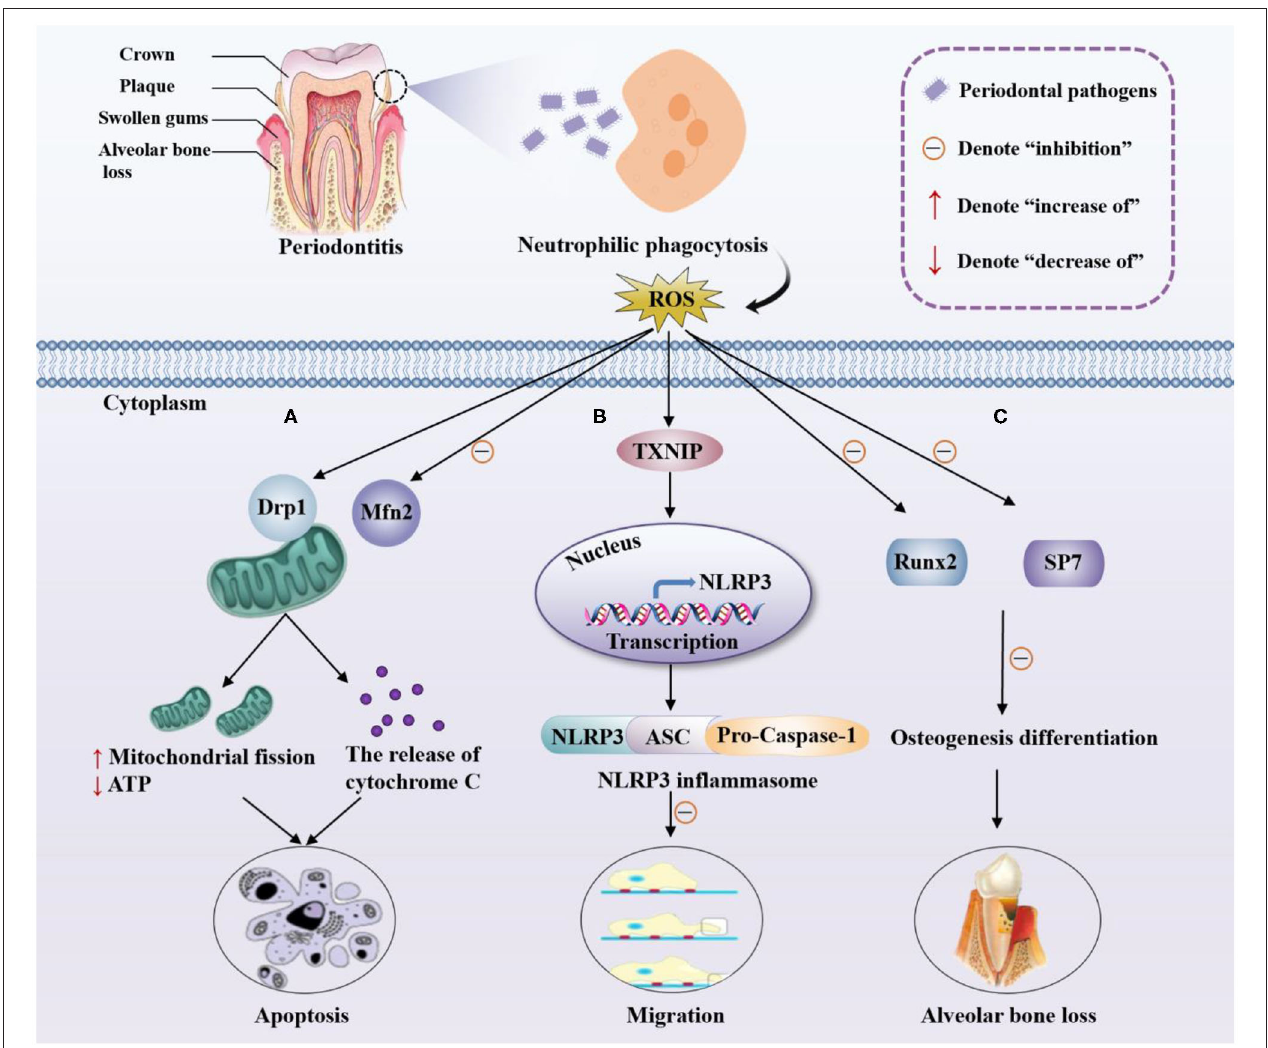
FIGURE 1 | Pathomechanism of periodontitis and ROS. Pathogens in dental plaque trigger the recruitment and activation of neutrophils, producing a large amount of ROS through phagocytosis. (A) ROS promote mitochondrial fission via the upregulation of Drp1 and downregulation of Mfn2 which is a mitochondrial fusion protein, reduce the production of ATP, and increase the release of cytochrome C, inducing the apoptosis of PDLSCs. (B) ROS trigger the combination of TXNIP and NLRP3, leading to the upregulation of the transcription of NLRP3, thereby activating the NLRP3 inflammasome and ultimately inhibiting the migration of PDLFs. (C) ROS inhibits the expression of osteogenic markers Runx2 and SP7, inhibiting the osteogenic differentiation of periodontal membrane stem cells, which cause alveolar bone